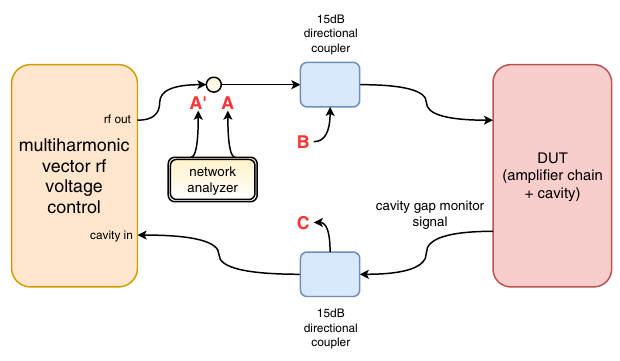
FIG. 14. Commissioning setup.